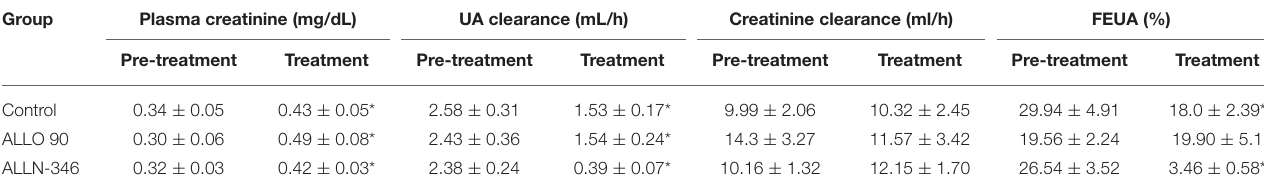
TABLE 2 | Pre- and post-treatment renal test parameters in uricase/UrOx deficient mice in the 19-day study. Group Plasma creatinine (mg/dL) UA clearance (mL/h) Creatinine clearance (ml/h) FEUA (%) Pre-treatment Treatment Pre-treatment Treatment Pre-treatment Treatment Pre-treatment Treatment Control 0.34 ± 0.05 0.43 ± 0.05* 2.58 ± 0.31 1.53 ± 0.17* 9.99 ± 2.06 10.32 ± 2.45 29.94 ± 4.91 18.0 ± 2.39* ALLO 90 0.30 ± 0.06 0.49 ± 0.08* 2.43 ± 0.36 11.57 ± 3.42 19.90 ± 5.1 26.54 ± 3.52 3.46 ± 0.58*